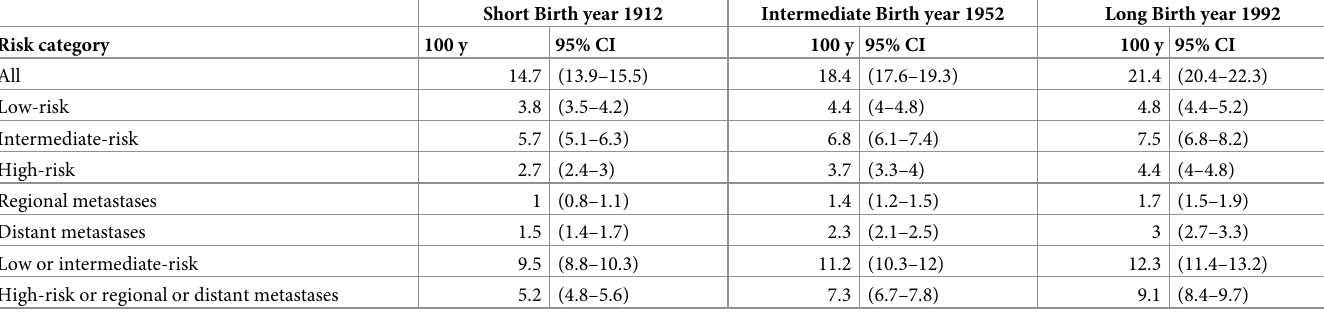
Table 2. Lifetime-risk of prostate cancer overall and per category according to life expectancy for three birth cohorts.